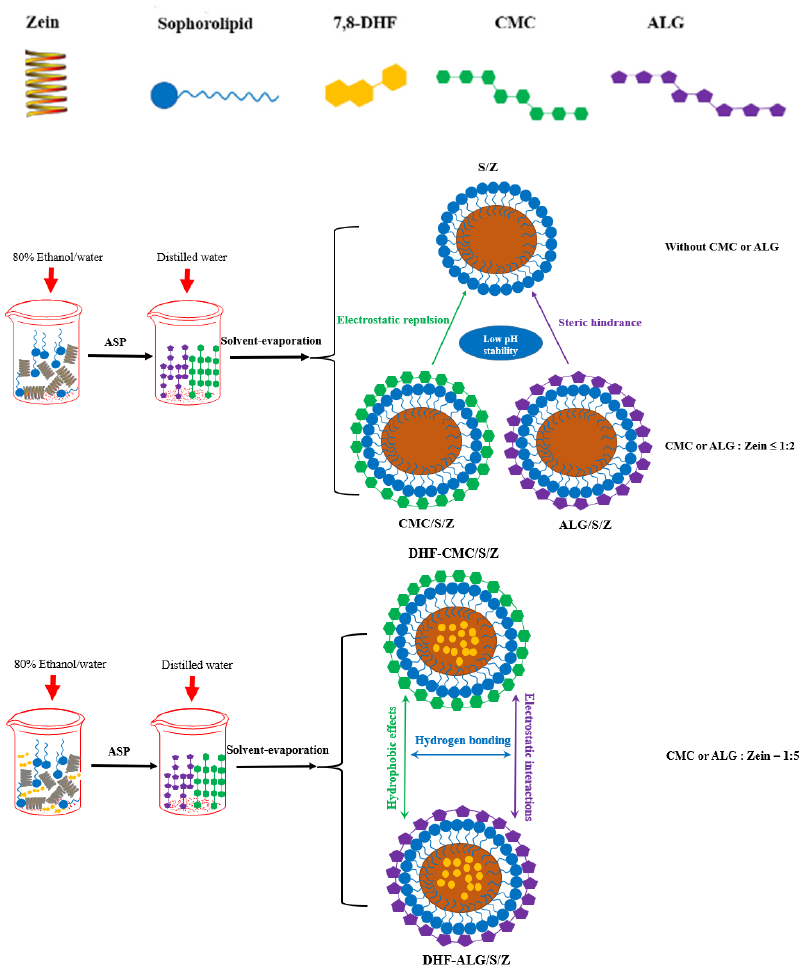
Figure 7. An illustration of the formation and stability mechanism of DHF-CMC/S/Z and DHF- ALG/S/Z.